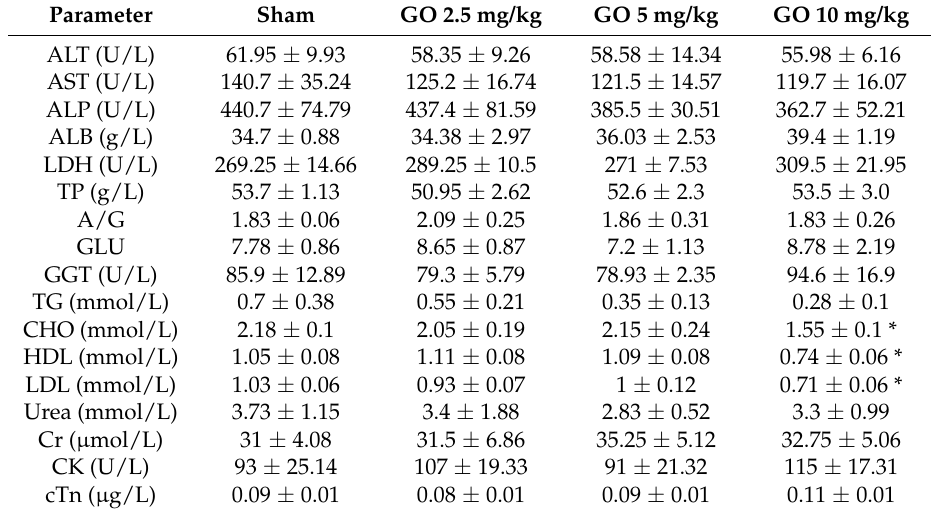
Table 6. Clinical chemistry parameters in rats following injection of GO in the seven-day subchronic toxicity